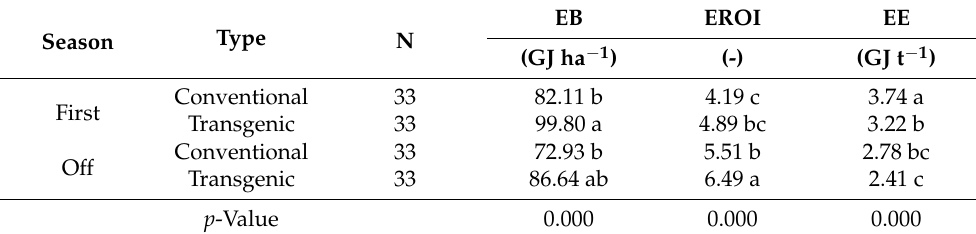
Table 3. Comparison of first and second season, conventional, and transgenic corn indicators. Season